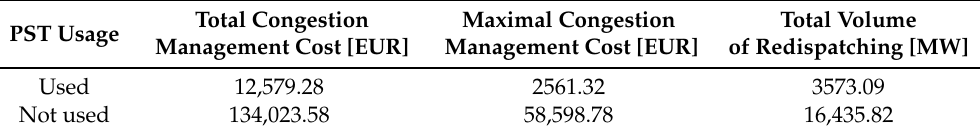
Table 2. Comparison of congestion management costs aggregated over 24 grid scenarios, maximal congestion management costs across 24 grid scenarios, and total redispatch volumes across 24 grid scenarios with and without the use of phase-shifting transformers (PSTs). Source: own calculations.